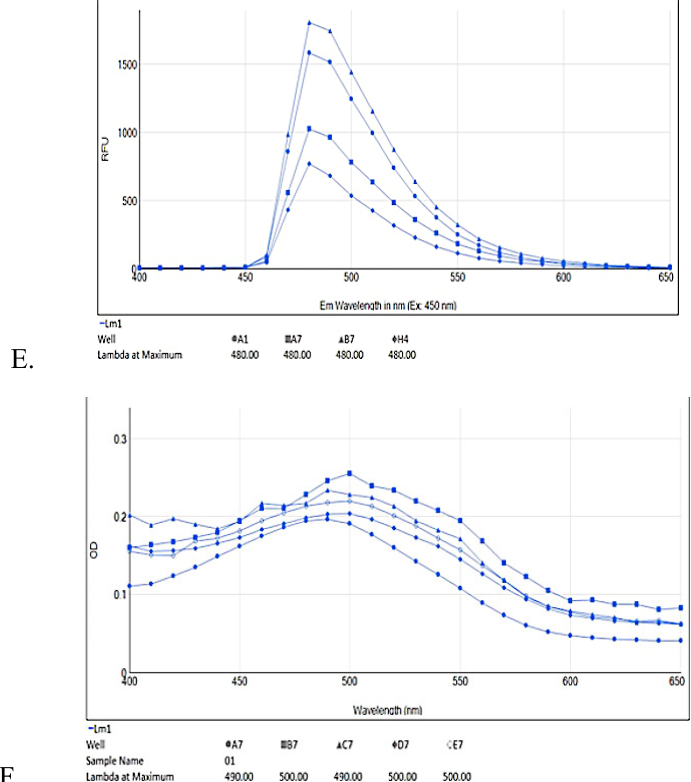
Figure 6. ThT fluorescence emission spectra ( A , C , E ) alongside red shift of Congo red dye ( B , D , F ) upon A β 42 fibril formation with different test compound concentrations; RES (6A) ThT : A1—A β 42 only, G1—A β 42 + RES 11 μ M, F1—A β 42 + RES 22 μ M, E1—A β 42 + RES 44 μ M; (6B) Congo red (CR):